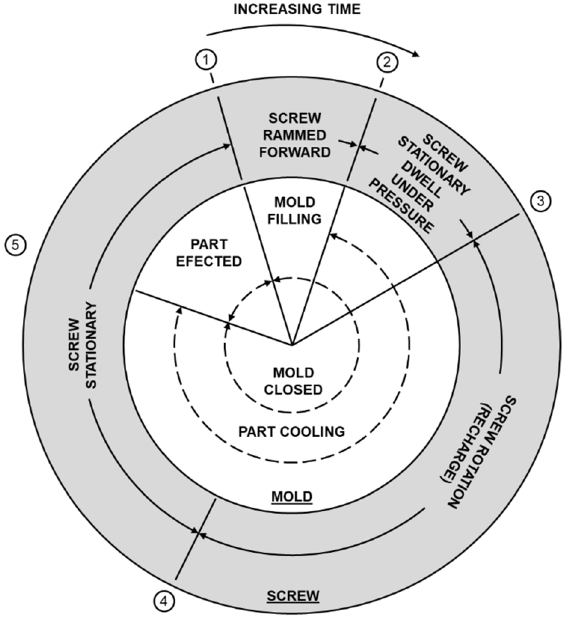
Figure 2. Injection molding process [16].